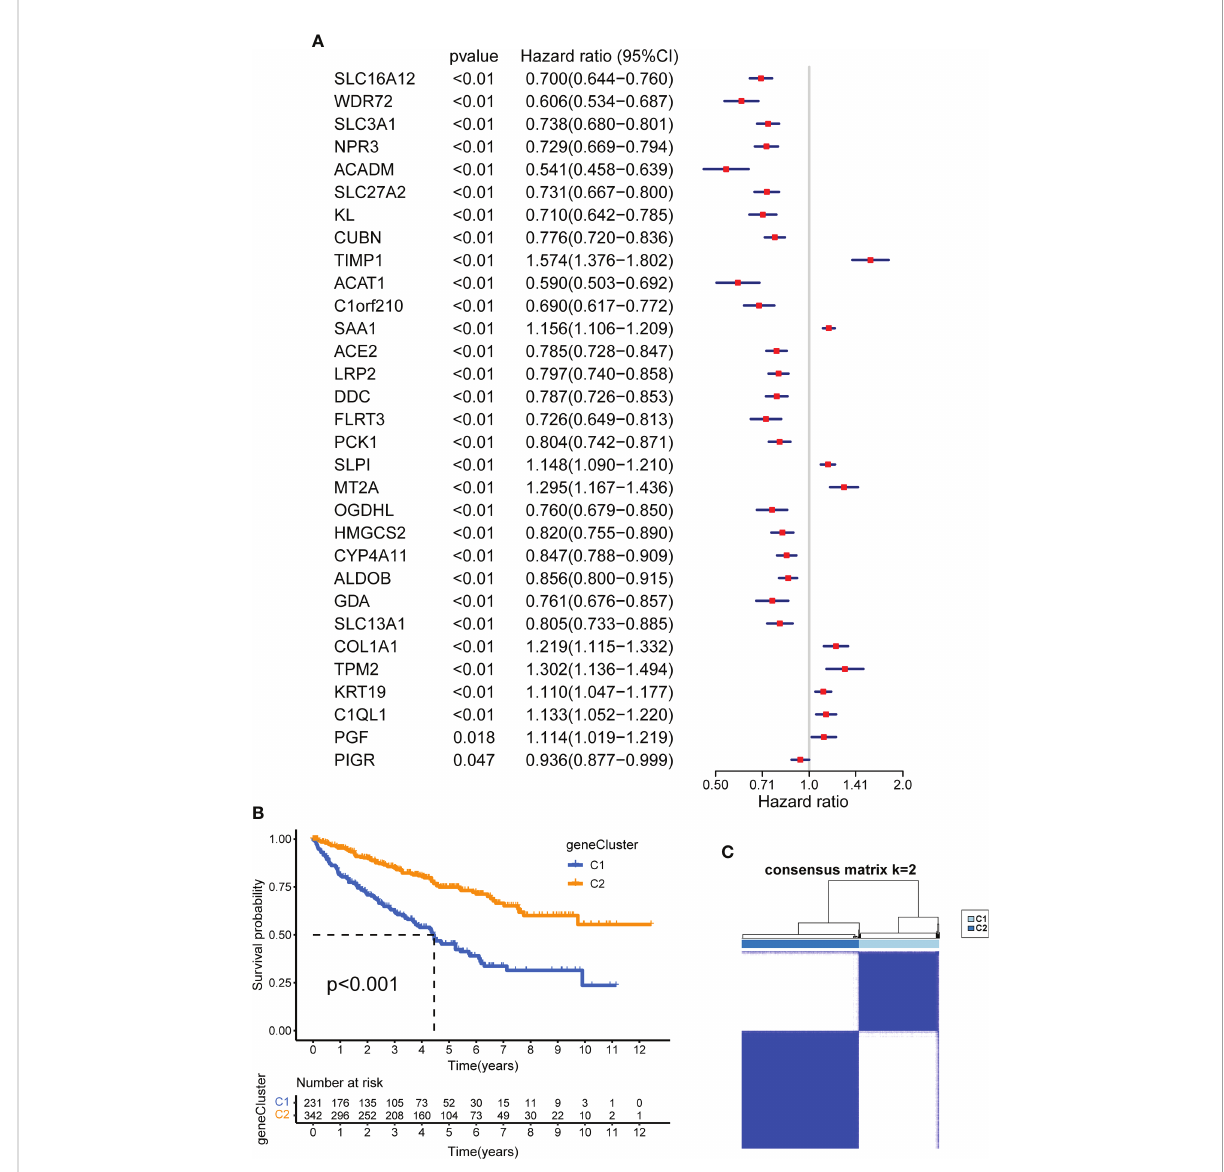
FIGURE 6 Construction of CSRG gene subtypes and prognostic analysis. (A) Univariate COX regression analysis of 31 DEGs to screen CSRGs. (B) Kaplan – Meier curves for the two gene subtypes (OS, Log-rank test, p < 0.001). (C) consensus matrix that divides all samples into two geneclusters (k=2). CSRG, cuproptosis subtypes related gene; DEG, differentially expressed